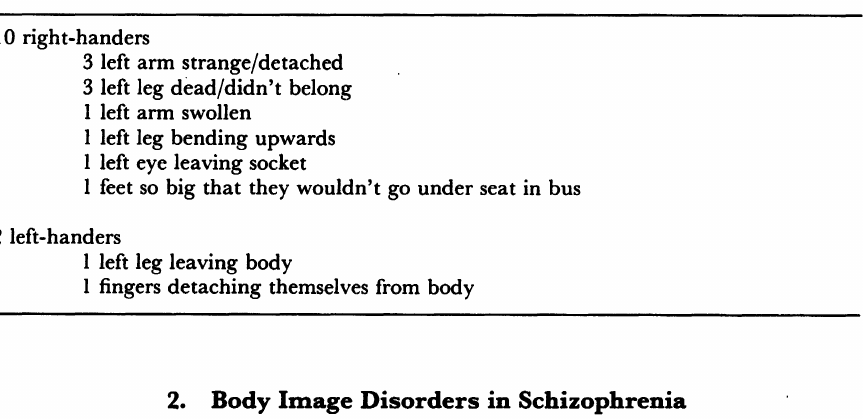
TABLE 4. Anomalous bodily experiences in 12 patients with right-sided lesions (Hecaen and Ajuria guerra, 1952)